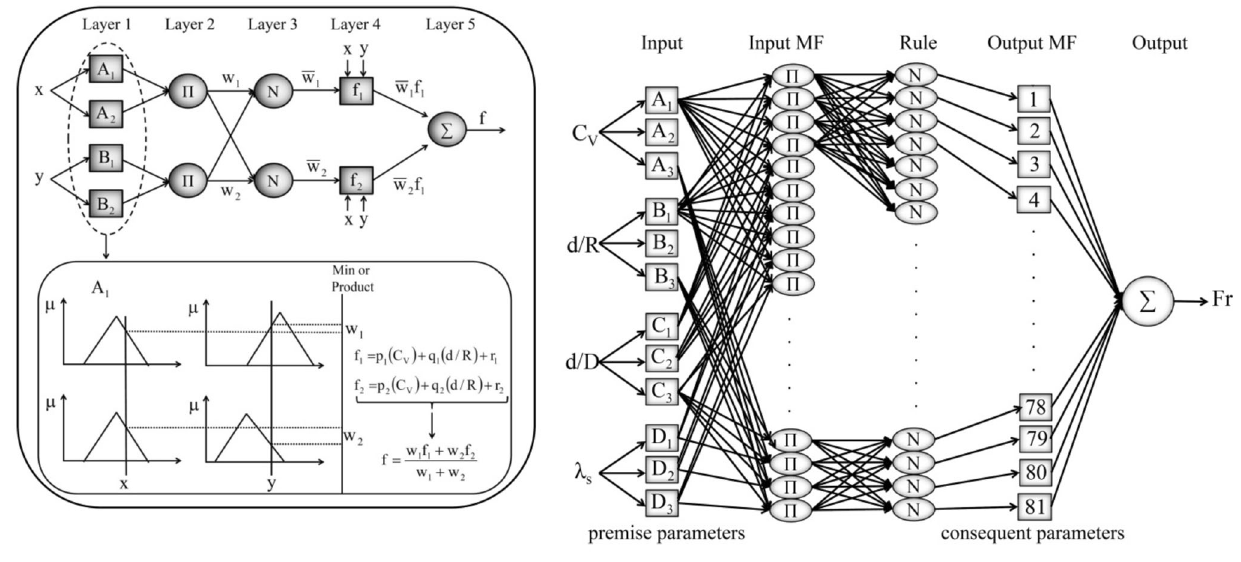
Fig. 1 ANFIS structures (general and